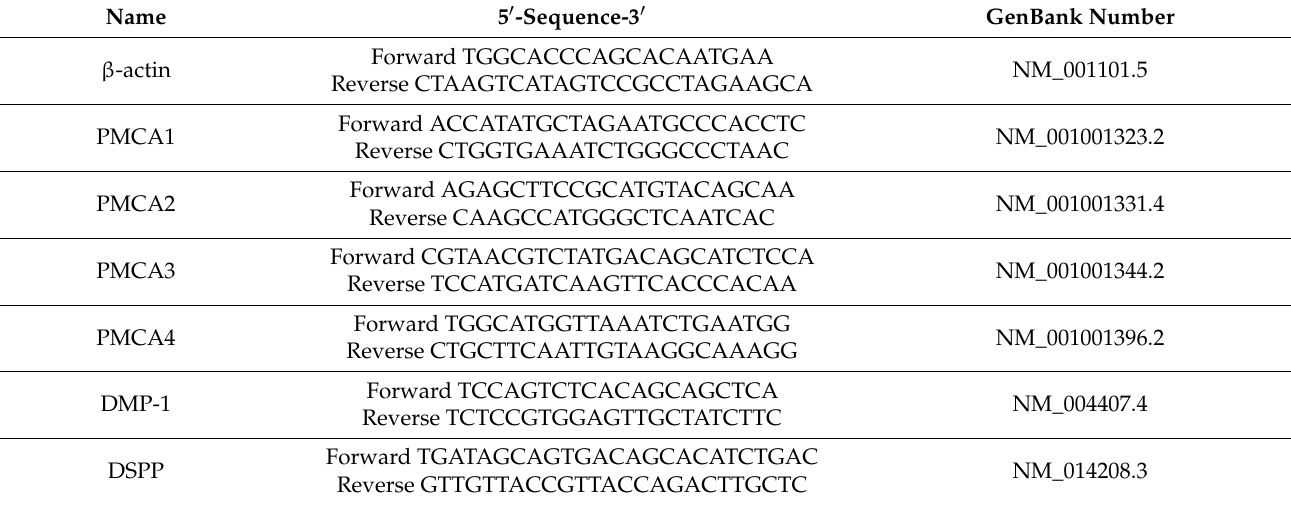
Table 1. Primer sets for real-time RT-PCR: plasma membrane Ca 2+ ATPase (PMCA) and odontoblast marker